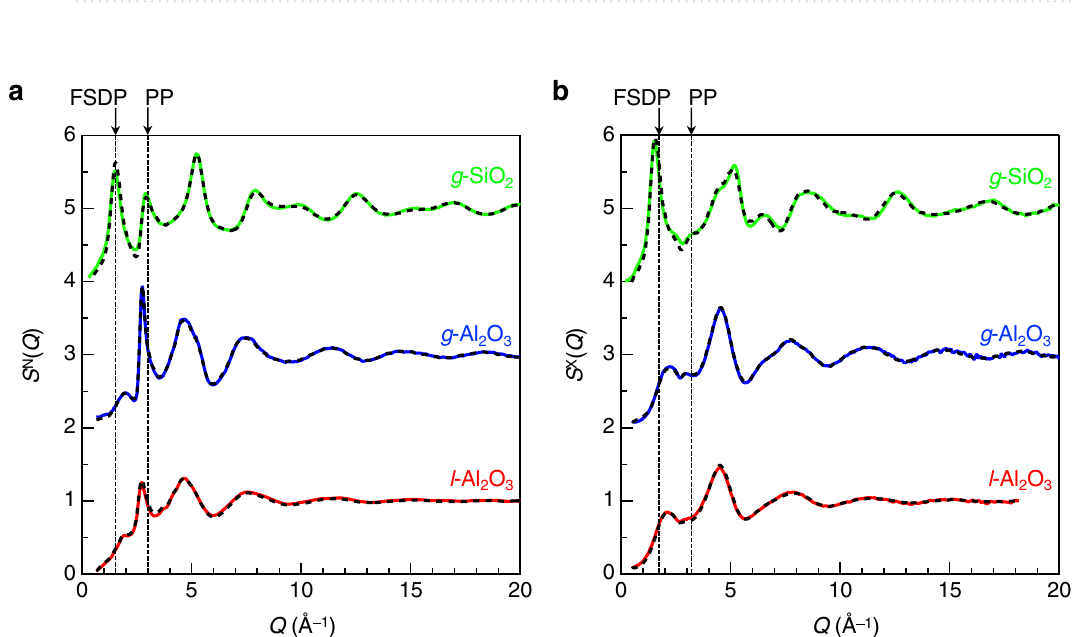
Figure 2. ( a ) Neutron total structure factors, S N ( Q ), together with the results of the MD–RMC simulations for g -Al 2 O 3 , l -Al 2 O 333 , and g -SiO 25 . ( b ) X-ray total structure factors, S X ( Q ), together with the results of the MD– RMC simulations for g